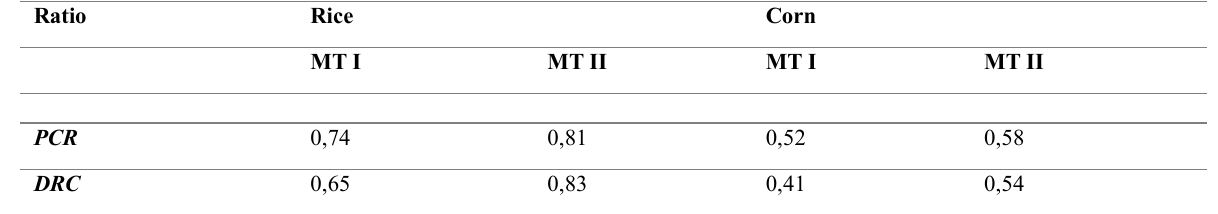
Table 5 : Indicators ofcompetitiveness strategic food commodities in Lampung Province, 2016/2017 Ratio